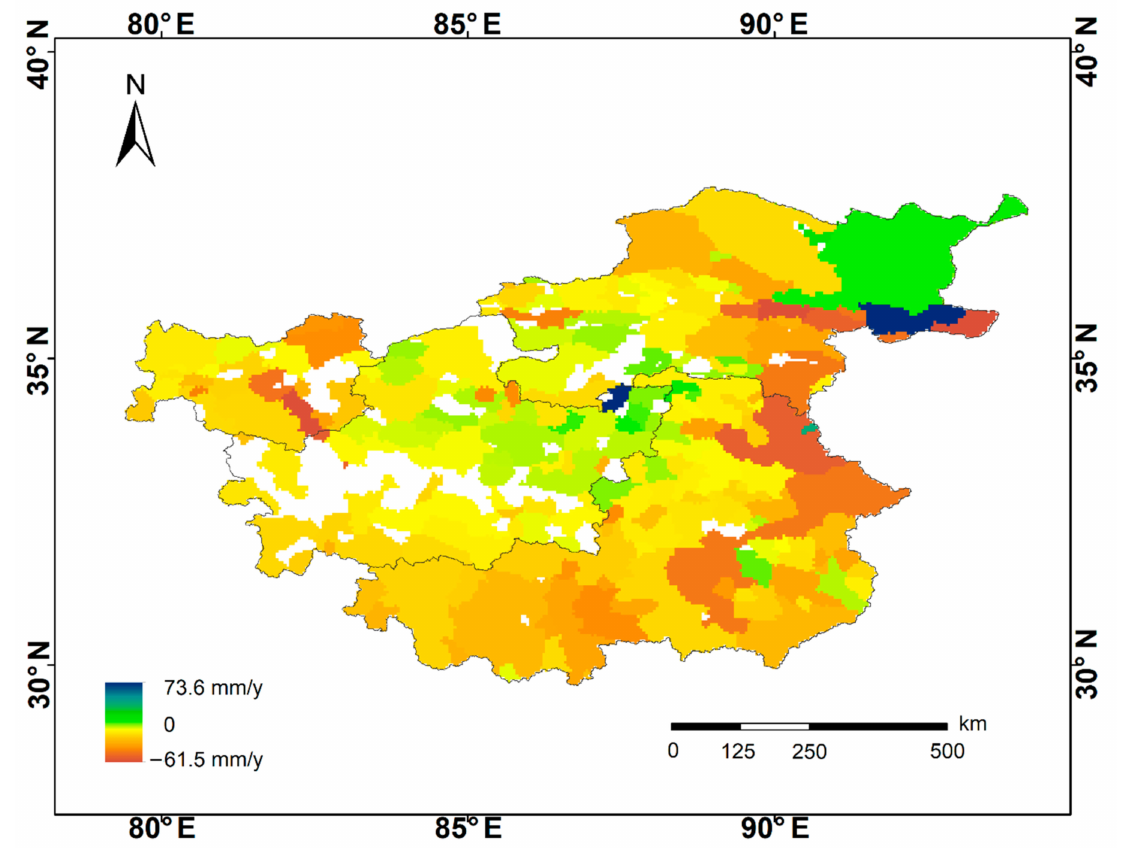
Figure 7. The difference between terrestrial water storage change and lake water storage change